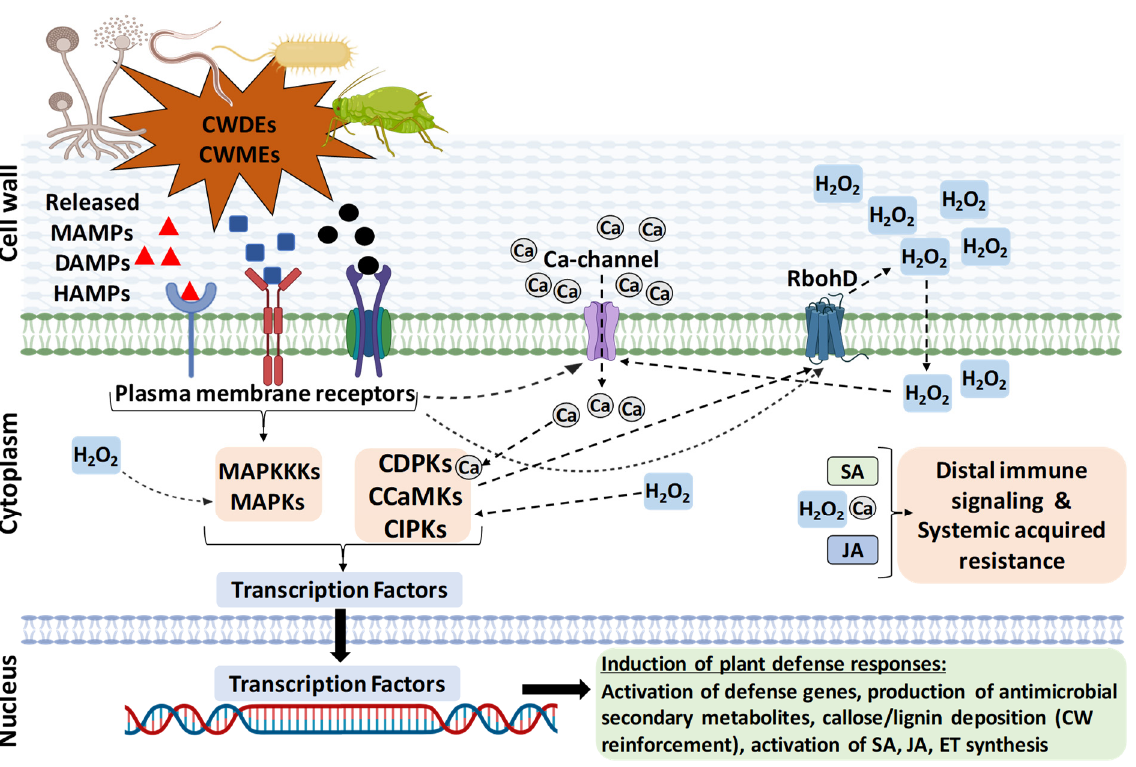
Figure 1. An overview of plant defense pathway triggered by perturbation of cell wall integrity during biotic stresses. The DAMPs, MAMPs, or HAMPs elicitors released due to biotic stresses are sensed through the plasma-membrane-localized pattern-recognition receptors (PRR) that activate the host defense pathway. The elicitor binding to PRRs activates a series of events, such as activation of Ca-channels and Ca influx, activation of reactive oxygen species production (ROS burst; H 2 O 2 ), and protein kinases (MAPKs) cascade activation, and these are inter-linked with each other. The MAPK and Ca-dependent kinase (CDPKs, CCaMKs, and CIPKs) cascades further activate transcriptional reprogramming, defense-related PTI genes, reinforcement of cell wall (callose and lignin deposition), generation of anti-microbial secondary metabolites, and activation of ET, SA, and JA hormone synthesis. Locally activated immunity is amplified through these hormones. Immunity may also involve the spread of defense responses to distal tissues, resulting in systemic acquired resistance (SAR). It should be emphasized that a general view of only the pattern triggered immunity is described here and that each pathosystem may involve specific molecular interactions.